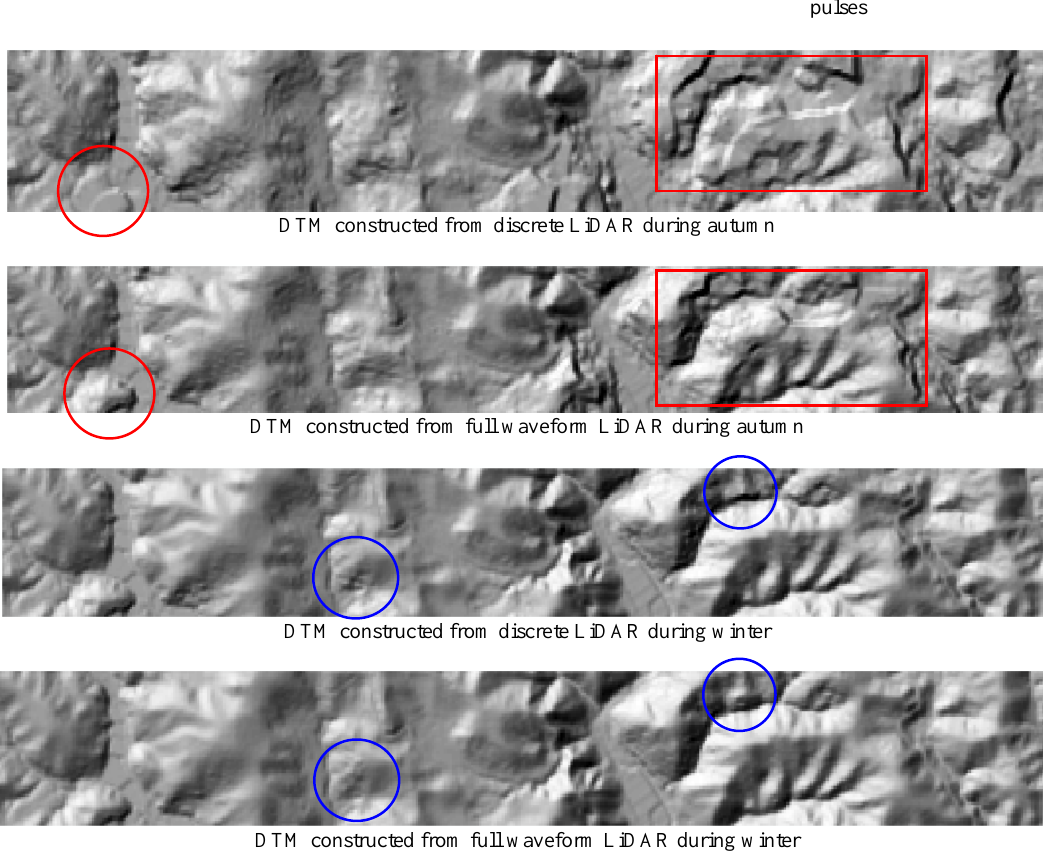
Figure 5. Comparing discrete and full waveform